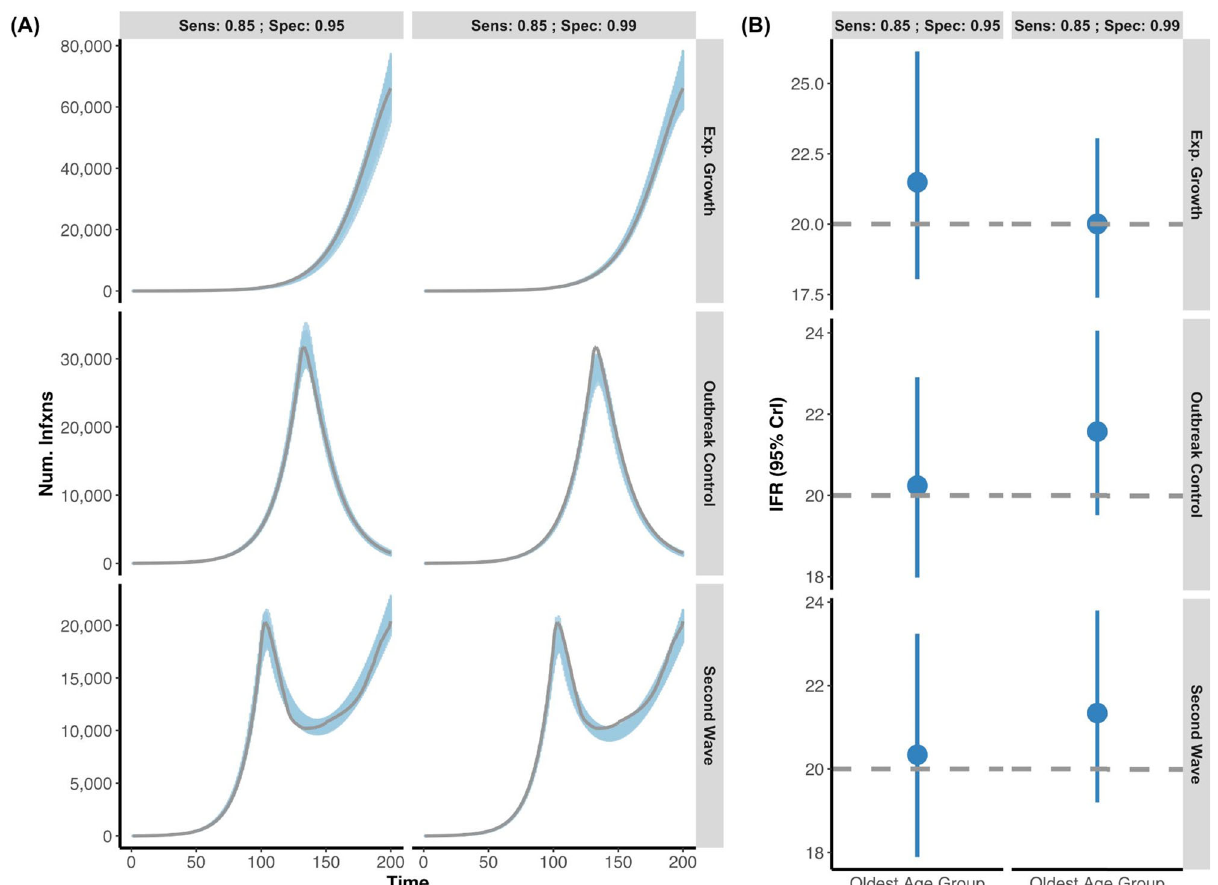
Fig. 2 Posterior daily infections and IFR estimates from simulated data without seroreversion. A Using simulated data, we created three outbreak scenarios where individuals who seroconverted could not serorevert: exponential growth, outbreak control, and second wave (grey lines are simulated infection input) under two different serologic tests (Sensitivity: 85%; Speci fi city 95% vs. Sensitivity: 85%; Speci fi city 99%). The blue shading represents 100 posterior draws of the modelled infection curve, where draws were selected based on their posterior probability. B The inferred median and 95% credible intervals (blue) versus the simulated true IFR (grey, dashed line) with two different serologic tests, in the oldest age group. For all epidemic scenarios considered, we assume that there are two seroprevalence surveys that range over days 120 – 130 and 170 – 180 and that 0.1% of the population was